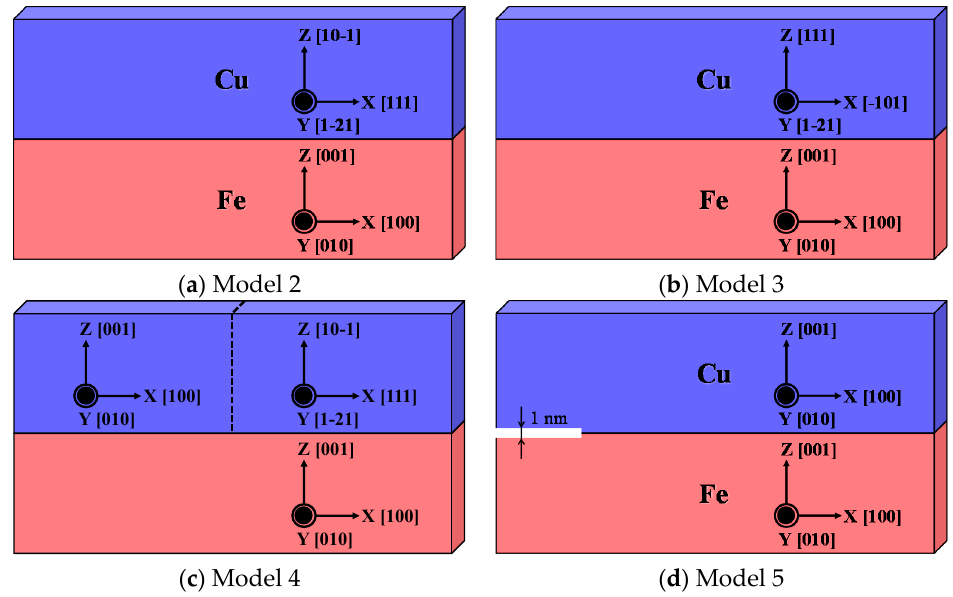
Figure 9. Other models with different crystal orientations ( a , b ), grain boundaries ( c ), and crack surfaces ( d ).